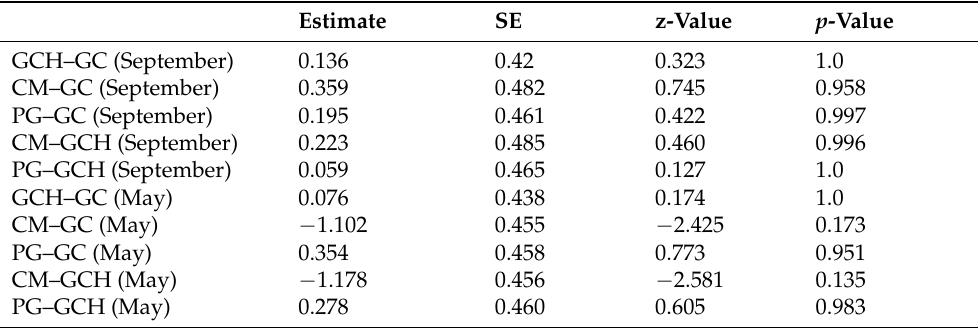
Table A9. Differences in the species richness of agrotopic carabid beetles, comparing grass–clover (GC) and grass–clover herbs (GCH) with each other, and in comparison to conventional maize (CM) and permanent grasslands (PG) in May/June and September.